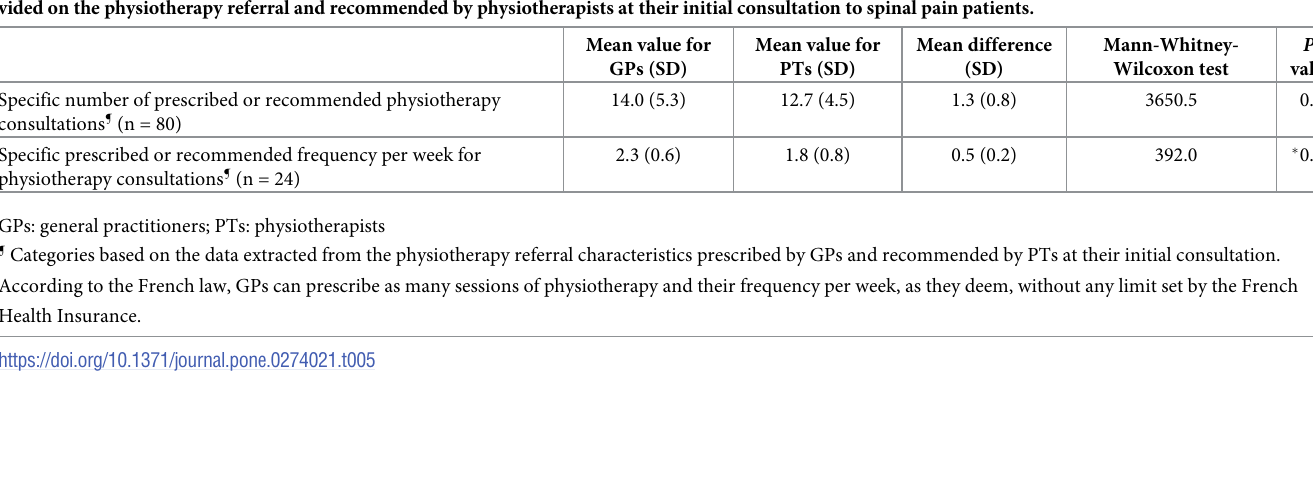
Table 5. Comparison of specific number and frequency per week for physiotherapy consultations prescribed by general practitioners based on information pro- vided on the physiotherapy referral and recommended by physiotherapists at their initial consultation to spinal pain patients.